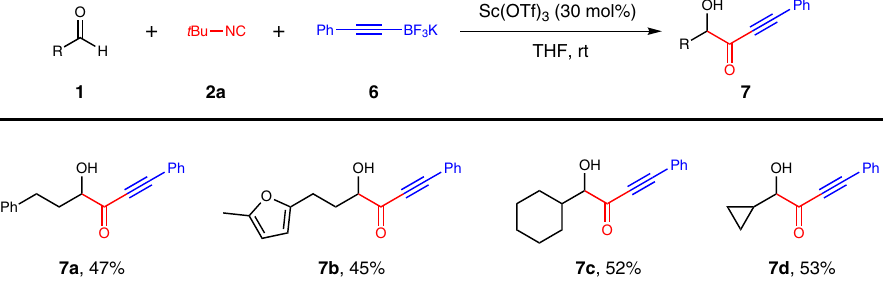
Fig. 4 Passerini-type reaction of alkynyl tri fl uoroborate salt. Reaction conditions: 1 (0.2 mmol, 1 equiv), 2a (0.5 mmol), 6 (0.6 mmol), and THF (1.5 mL) under an argon atmosphere for 12 hours unless otherwise speci fi